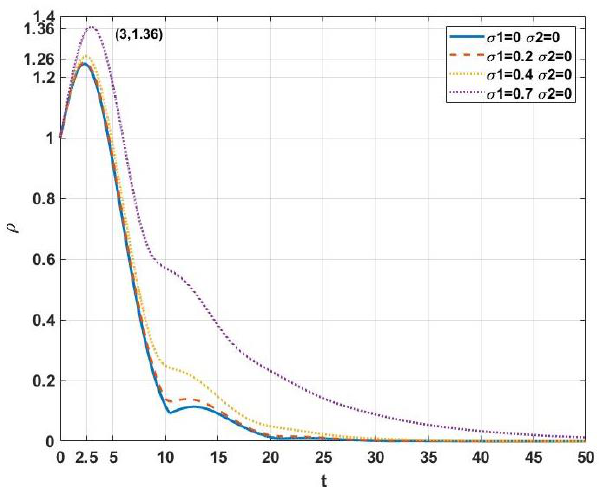
Figure 7. The root-mean-square amplification envelope of system (7) when only the prey is perturbed.